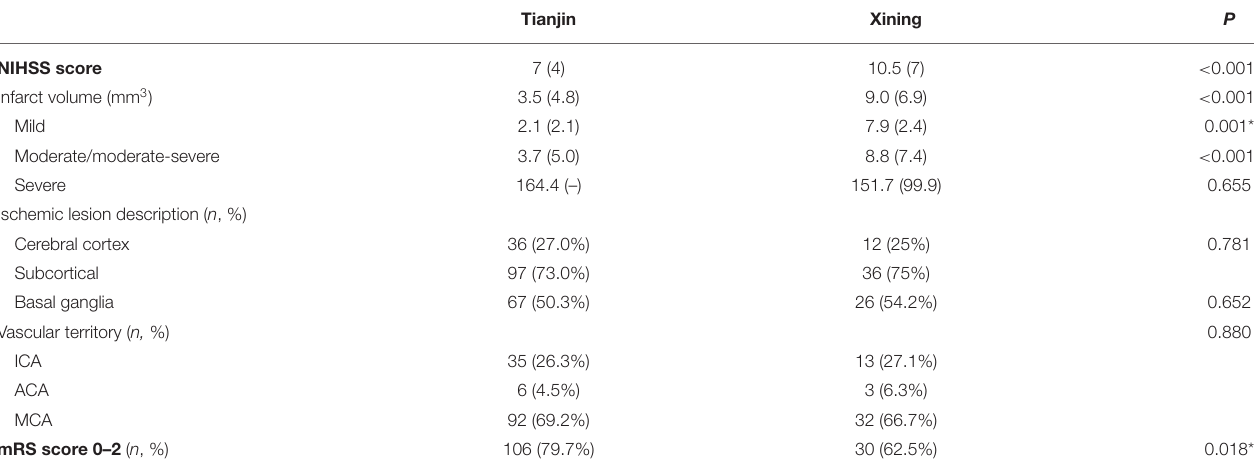
TABLE 4 | Differences in NIHSS score, Infarct volume, Ischemic description and mRS score at different